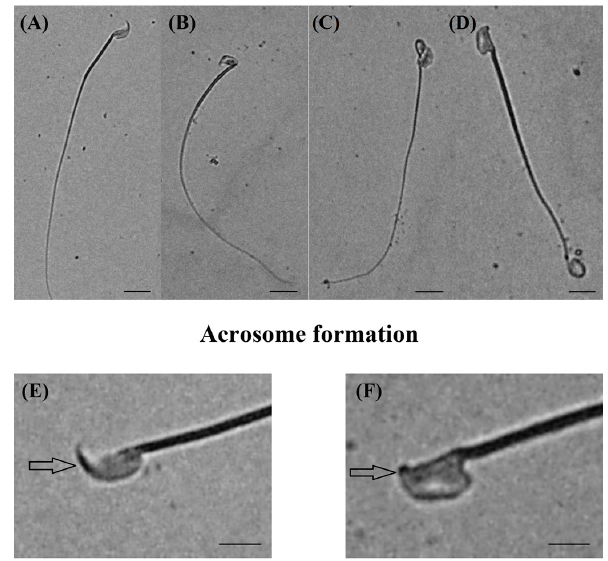
Figure 4. Sperm morphology. ( A , E ) Normal sperm, pointed out by arrow showing acrosome formation as dark black color on sperm head; ( B ) abnormal sperm with bent head; ( C ) abnormal sperm with twisted head and neck; ( D ) abnormal sperm morphology with head damage and coiled tail; ( F ) arrow head showing abnormal formation of acrosome.